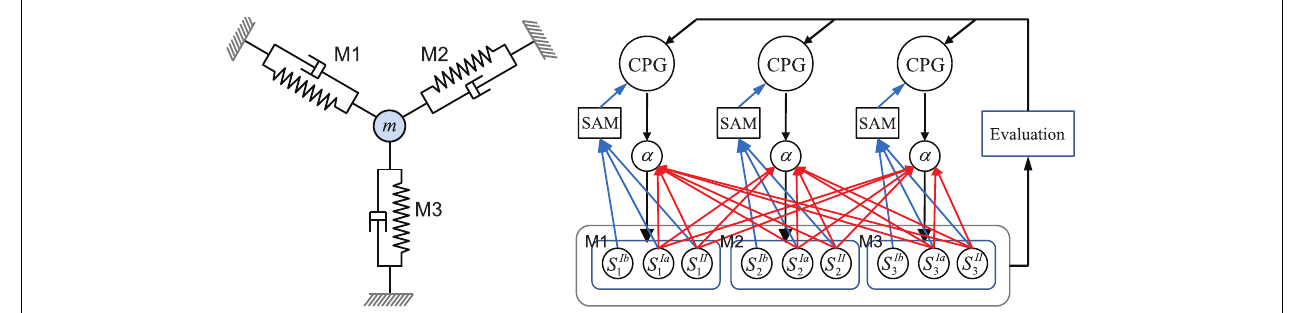
force information. Proprioceptive signals are integrated and modulated by a sensor adaptation module (SAM) before being sent to the CPG. An evaluation signal modulates the global bifurcation parameter of the CPGs, which drives the system between stable and chaotic regimes.The afferent weights (red arrows) of the alpha motor neurons are subject to adaptation which is guided by the evaluation signal.The architecture can be extended for a physical system of arbitrary degrees of freedom. See text for further